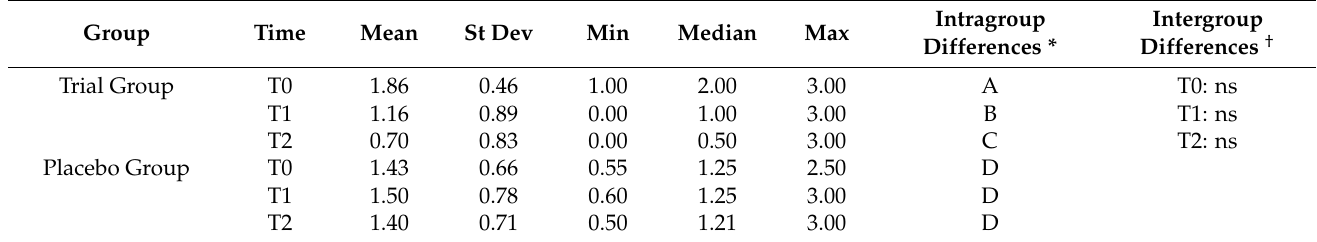
Table 5. Descriptive statistics of Bleeding Score measurements (BS).